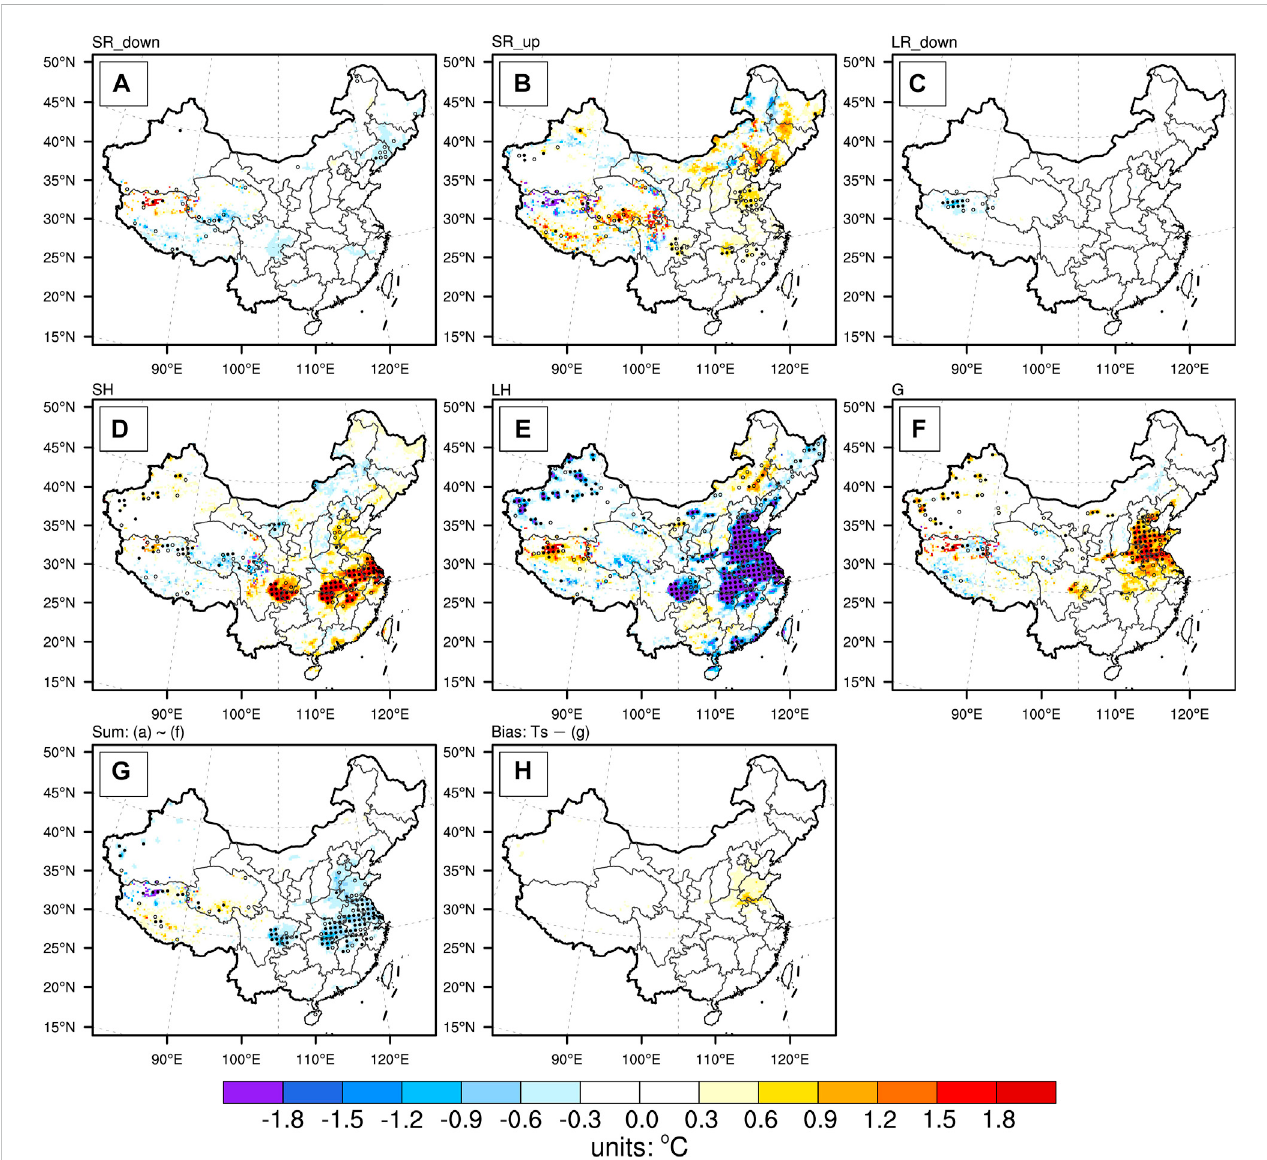
FIGURE 7 Ensemblemeanresultsoftheirrigation-inducedmultiyearmeanchangesindaytime(06UTC)surfacetemperatureduetochangesinthesurfaceenergy budget components: (A) downward shortwave radiation, (B) upward shortwave radiation, (C) downward longwave radiation, (D) sensible heat fl ux, (E) latent heat fl ux, (F) ground heat fl ux, (G) sum of (A – F) and (H) errors of the decomposed temperature metric (i.e., simulated land surface temperature minus (G) ), units: ° C. The meanings of solid and hollow dots are the same as Figure